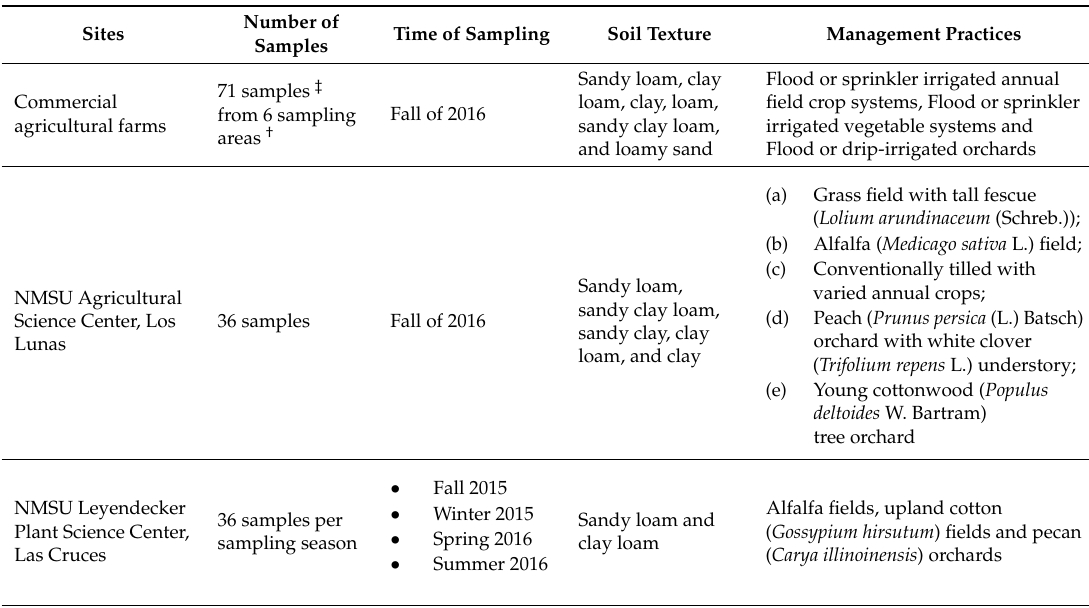
Table 1. The number of samples, time of sampling, soil texture, and crop management practices of the sampled agricultural